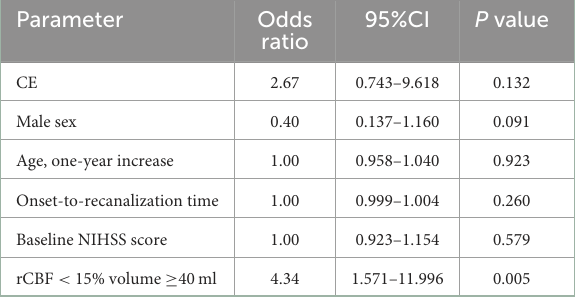
TABLE 4 Multivariate logistic regression analyses of variables associated with the occurrence of MLS.